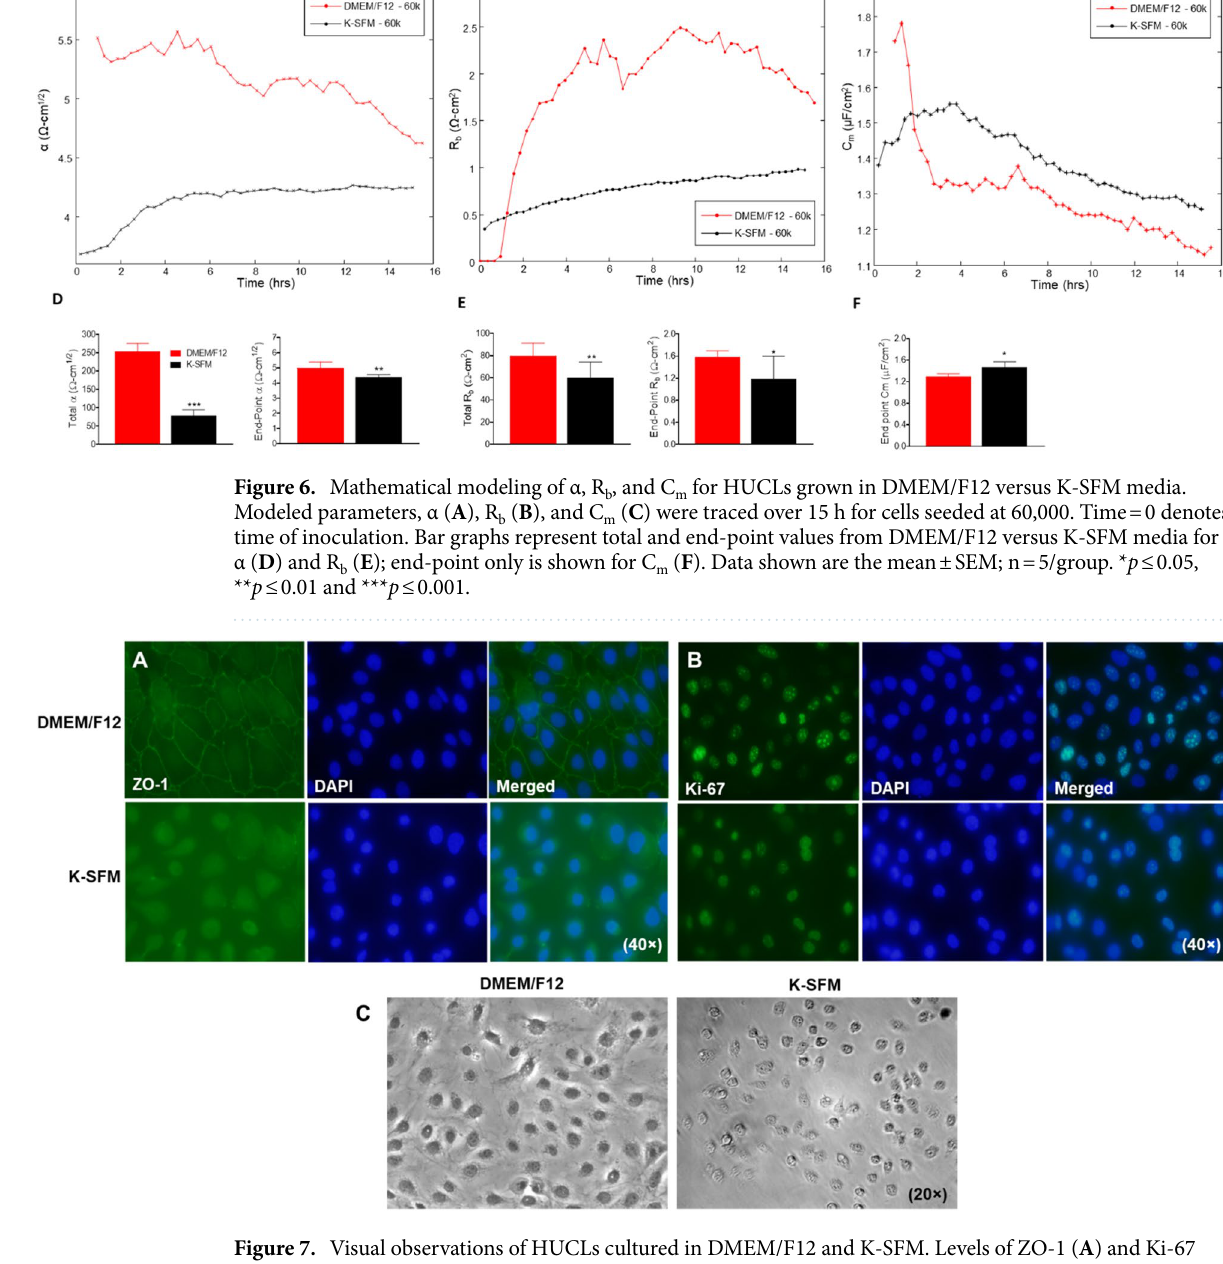
Figure 7. Visual observations of HUCLs cultured in DMEM/F12 and K-SFM. Levels of ZO-1 ( A ) and Ki-67 ( B ) were assessed by immunofluorescence after 5 days of culturing in either DMEM/F12 or K-SFM media. ZO-1 and Ki-67 are shown in green with nuclei of cells counterstained with DAPI shown in blue. Images are shown at 40 × . Phase-contrast microscopy ( C ) images of HUCLs grown in both DMEM/F12 and K-SFM are shown at 20 ×